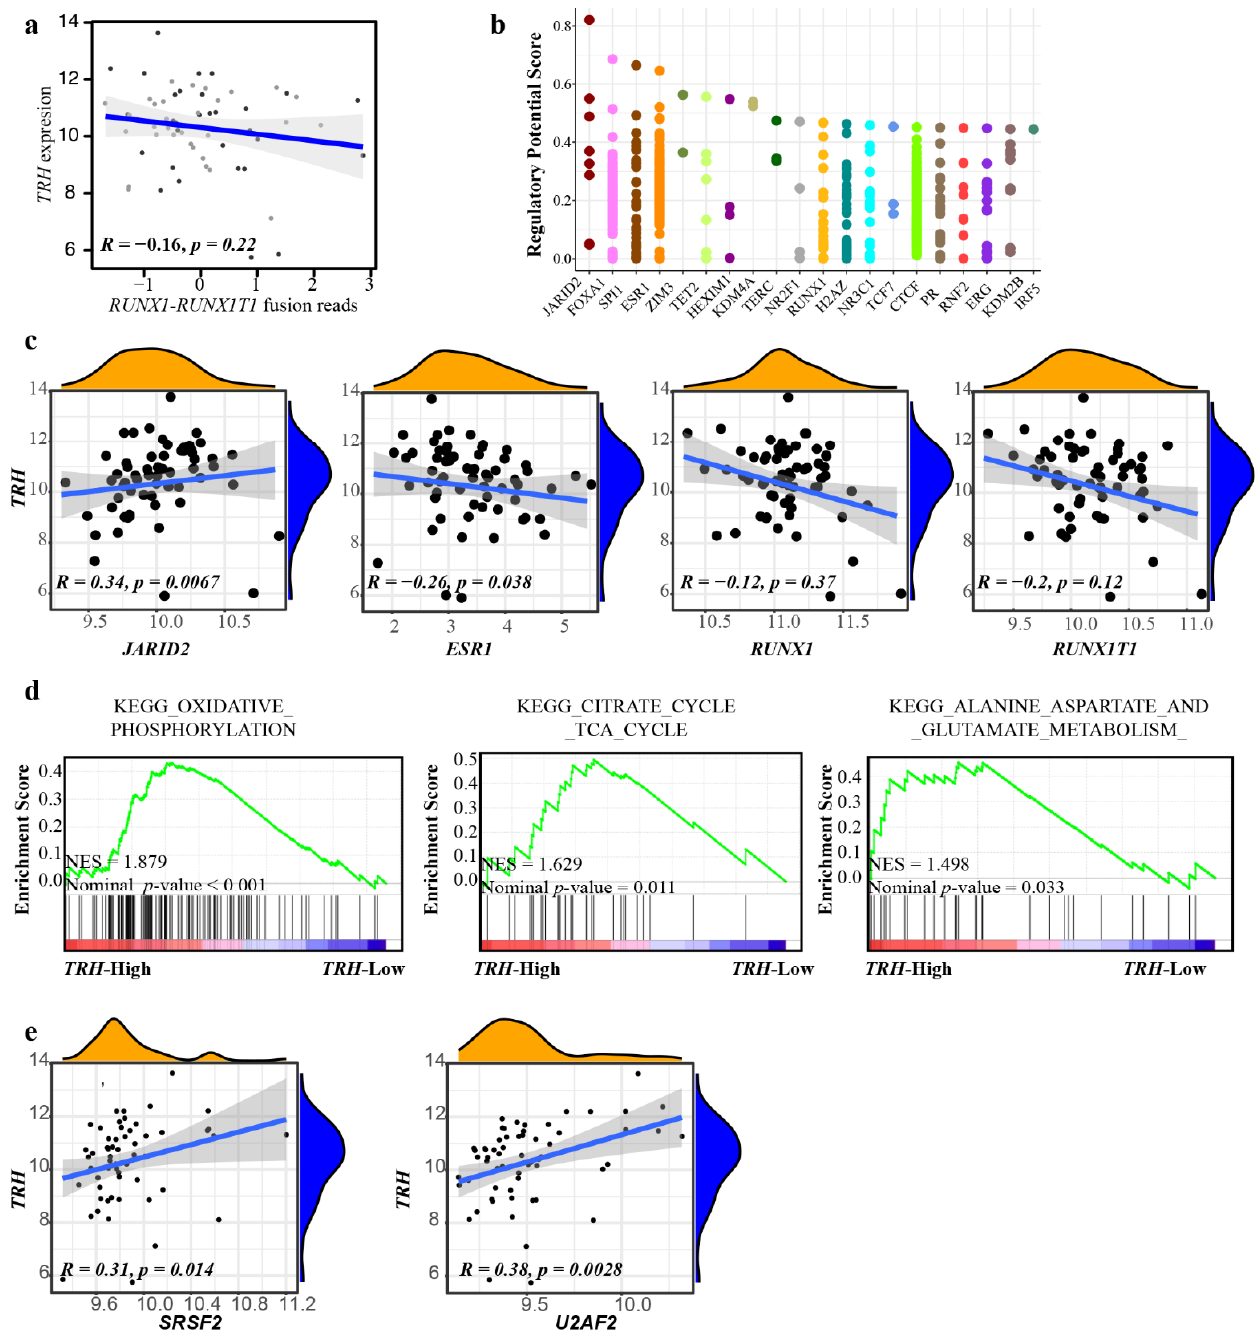
Figure 2. Regulation network analysis of TRH expression in RUNX1-RUNX1T1 AML patients . ( a ) Correlation analysis of TRH expression with RUNX1-RUNX1T1 fusion transcript expression based on the RNA-seq data of RUNX1-RUNX1T1 AML patients. Spearman’s correlation analysis and cor- relation coefficient ( R ) are shown. ( b ) Top 20 putative and potential transcription factors for TRH from ChIP-seq dataset based on the Cistrome. Y axis, the regulatory potential score. X axis, different factors. Each dot represents a ChIP-seq sample. ( c ) Correlation analysis of TRH expression with transcription factors in RUNX1-RUNX1T1 AML patients. Spearman’s correlation analysis and cor- relation coefficient ( R ) are shown. ( d ) Representative GSEA results of the TRH -high group in RUNX1-RUNX1T1 AML patients. Normalized enriched score (NES) and nominal p -values are shown. ( e ) Correlation analysis of TRH expression with splicing factors in RUNX1-RUNX1T1 AML. Spearman’s correlation analysis and correlation coefficient ( R ) are shown.